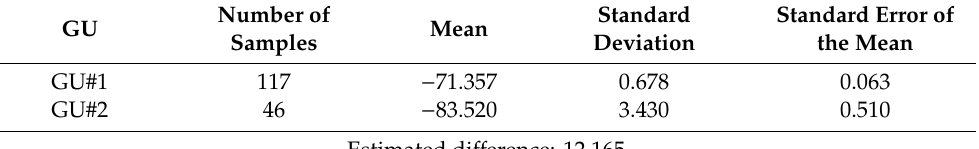
Table 2. Results of two-sample t-test for rotation frequency of current